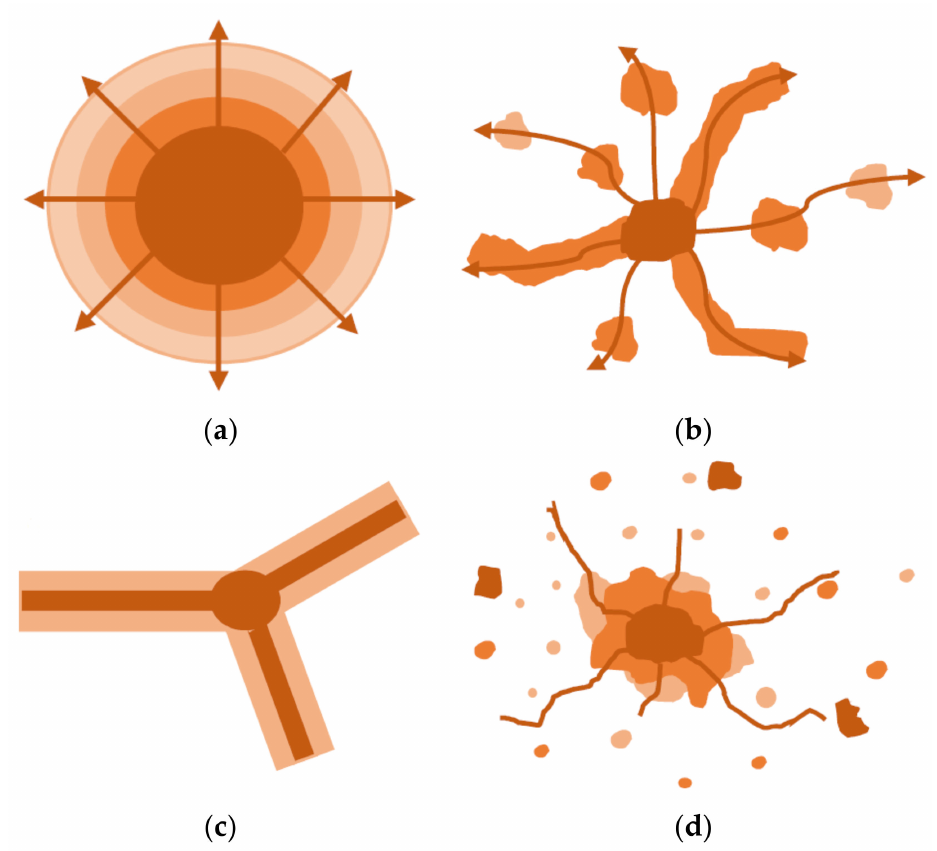
Figure 1. ( a ) Low-density development [35], ( b ) Leapfrog development [35], ( c ) Commercial ribbon development [35] and ( d ) Scattered development